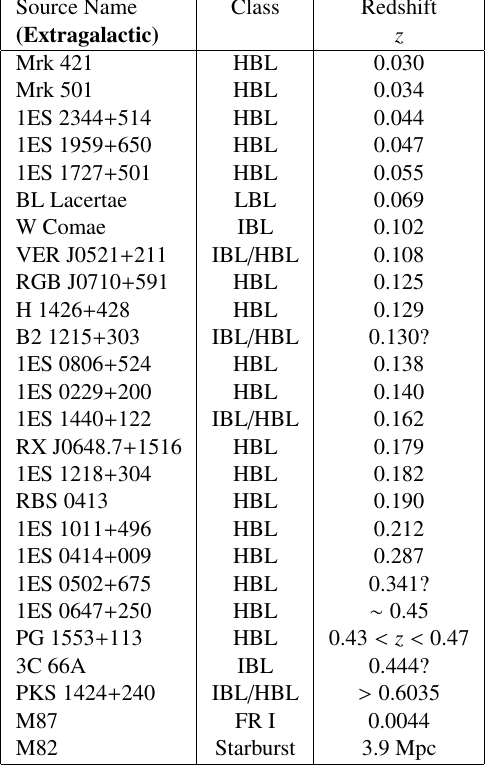
Figure 3. The VERITAS sky map of detected sources as of May 2013, in Galactic coordinates. The shaded area shows the region of visibility for VERITAS above 50 degree elevation. The ma- jority of the detected sources o ff the Galactic plane are blazars (shown in red).